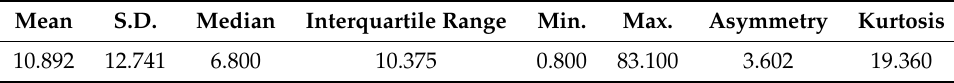
Table 6. Descriptive analysis for the charities data.